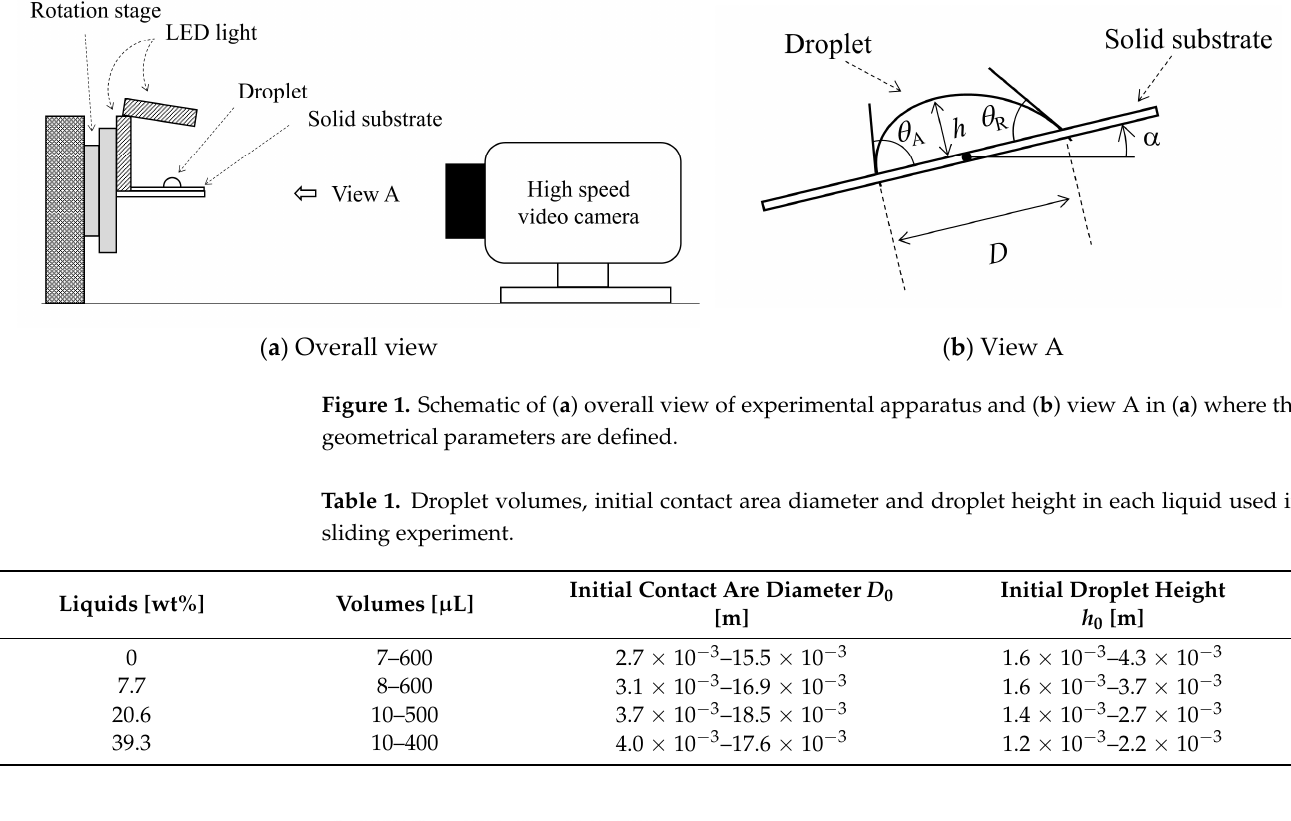
Table 1. Droplet volumes, initial contact area diameter and droplet height in each liquid used in sliding experiment.